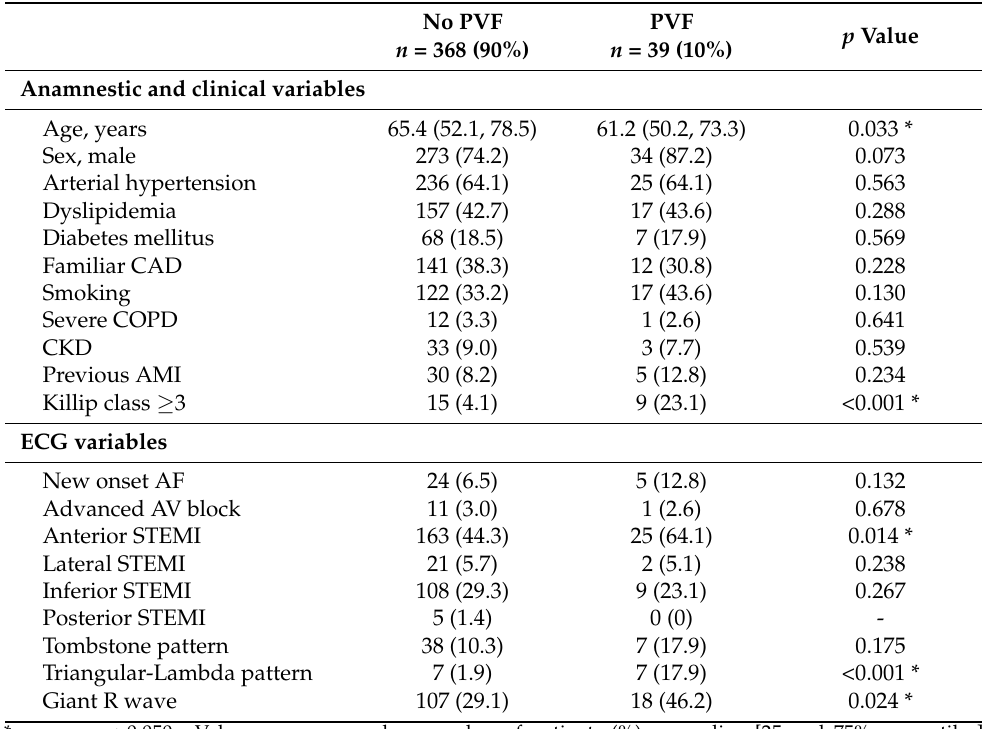
Table 2. Distribution of anamnestic, clinical, and electrocardiographic features among the groups with and without PVF.